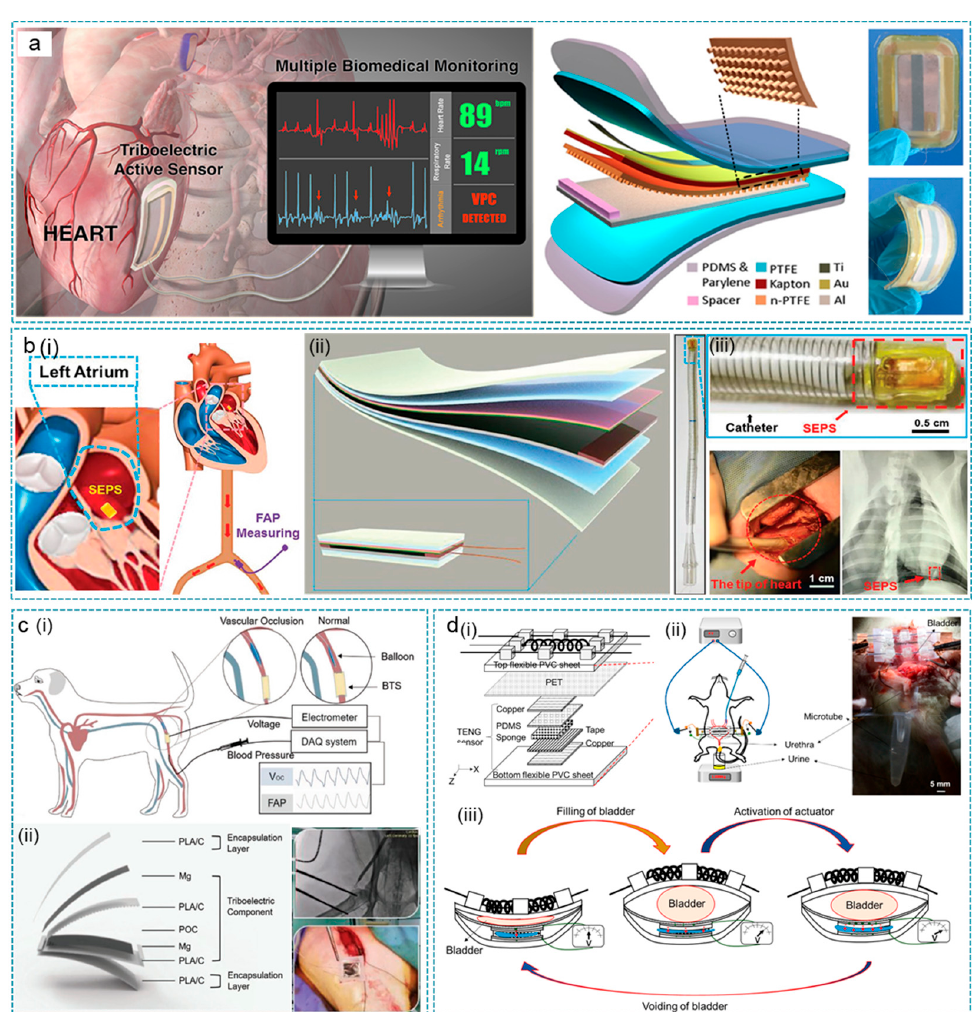
Figure 3. TENGs for implantable active sensors. ( a ) TENG as implantable self-powered cardiac sensors (iTES). The working principle (left) and structure (right) of the iTEAS. Reprinted with permission from Ref. [102]. Copyright 2016 American Chemical Society. ( b ) TENG as an implantable self-powered endocardial pressure sensor (SEPS). (i,iii) The SEPS implanted into an Adult Yorkshire swine’s heart. (ii) Schematic structure of the SEPS. Reprinted with permission from Ref. [103]. Copyright 2018 John Wiley & Sons. ( c ) TENG as a blood pressure sensor (BTS). The schematic diagram of BTS used for abnormal cardiac event identification (i) in a large animal and its structure (ii). Reprinted with permission from Ref. [93]. Copyright 2021 John Wiley & Sons. ( d ) TENG as a bladder pressure sensor. The schematic diagram about the structure (i) and working principle (iii) of the bladder pressure sensor. (ii) The bladder pressure sensor in vivo. Reprinted with permission from Ref. [104]. Copyright 2018 American Chemical Society.